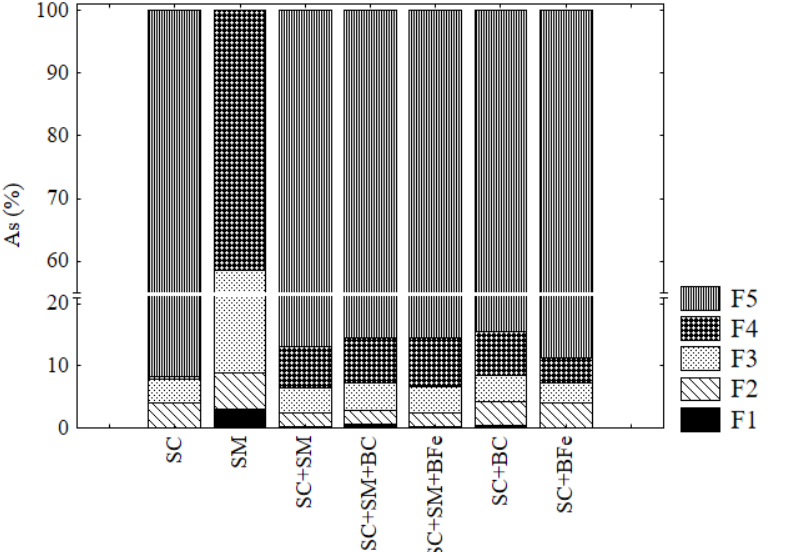
Figure 3. Fractionation of arsenic (As) in the soil after the experiment. F1: easily soluble; F2: adsorbed; F3: bound to amorphous and poorly crystallized Fe oxides and hydroxysulfates; F4: well-crystalline arsenates, oxides, and hydroxosulfates of Fe; F5: sulfides and arsenides. SC = contaminated soil, SM = forest soil, SC + SM = contaminated soil + forest soil, SC + SM + BC = contaminated soil + forest soil + biochar, SC + SM + BFe = contaminated soil + forest soil + biochar Fe impregnated, SC + BC = contaminated soil + biochar, SC + BFe = contaminated soil + biochar Fe impregnated.